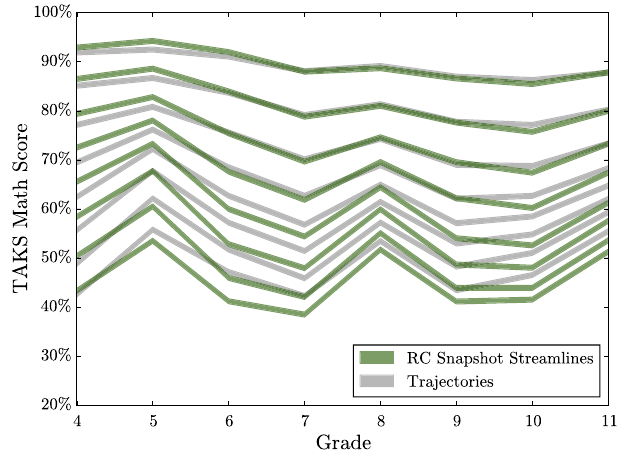
FIG. 11. RC snapshot streamlines for 2007 – 2009 and trajecto- ries for the 2012 cohort. The double peaks in 5th and 8th grades, due to SSI and AMI, are observed in both the trajectories and the RC snapshot streamlines. These interventions were provided to low-performing K – 8th grade